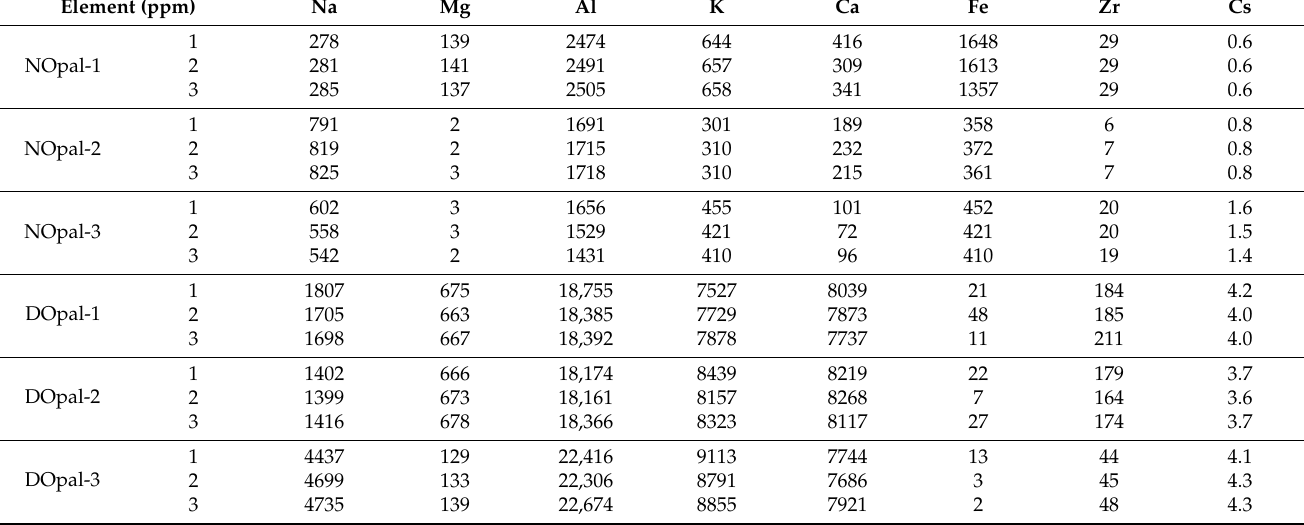
Table 6. Chemical composition (ppm) of six opal samples, as obtained by